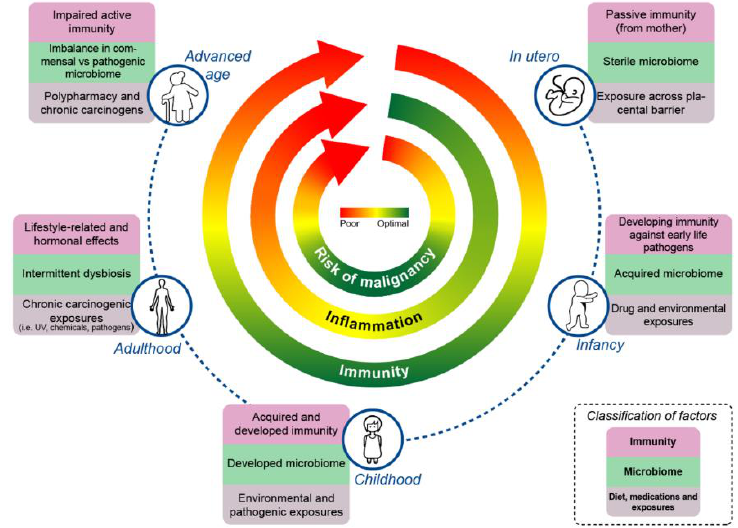
Figure 1. Interplay of the microbiome, inflammation, and immunity leading to a risk of malignancy across the lifespan.